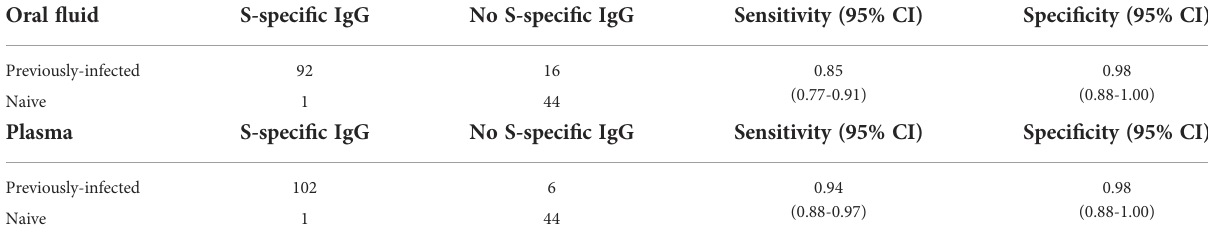
TABLE 3 Sensitivity and speci fi city of MSD ® immunoassay with 95% con fi dence intervals. Oral fl uid